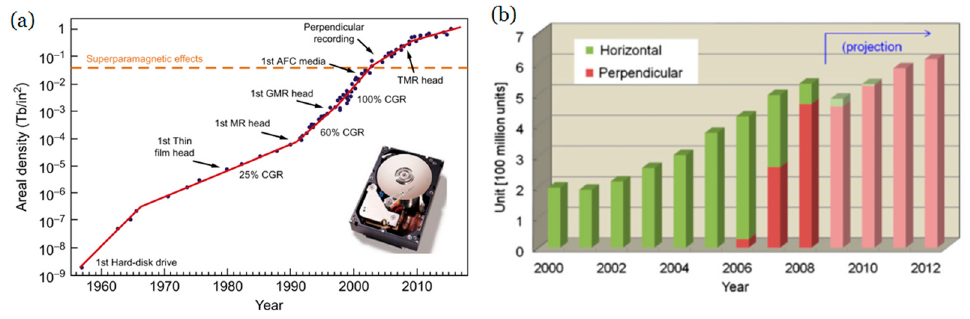
Figure 1. ( a ) Time evolution of the areal bit density since the first commercial magnetic hard drive disk became available in the late 1950s. The inset shows a top view of the IMB hard drive Ultrastar 36ZX with the cover removed. This model was developed in 1999 using GMR head technology and reached an areal density of 3.5 Gb/in 2 . Reprinted from [1] with permission from Elsevier. ( b ) Shift to perpendicular magnetic recording in hard disks. Reprinted with permission from ref. [6] 2012 Elsevier.